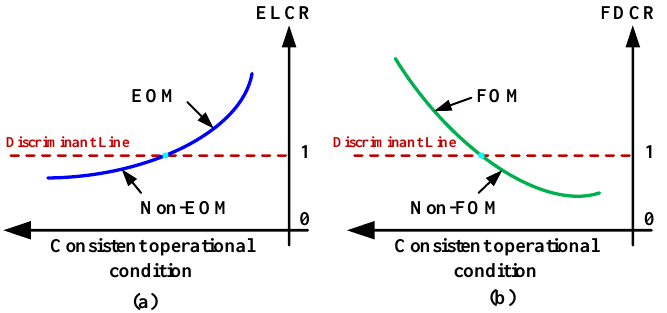
Figure 5. Criteria for electromechanical oscillation mode (EOM) and FCWG oscillation mode (FOM) identification: ( a ) EOM identification; ( b ) FOM identification.